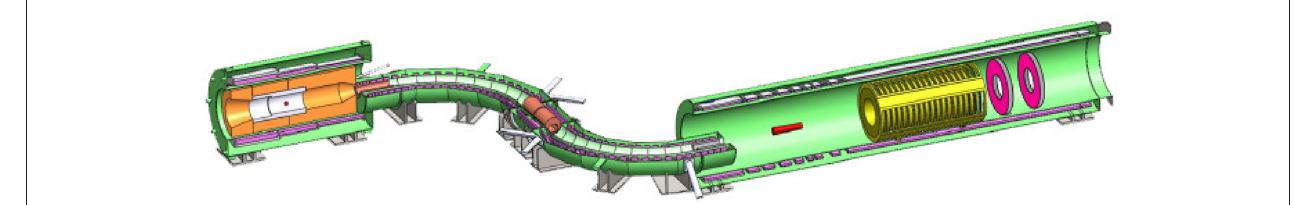
FIGURE 3 | The Mu2e Solenoid system, also showing the tracking detector, calorimeter, and stopping target. From Bartoszek et al. [8].